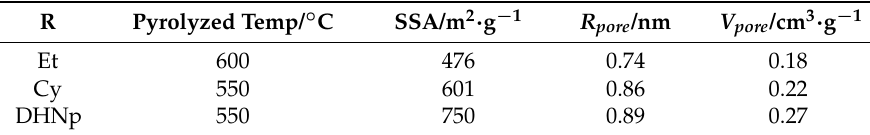
Table 5. Textural properties of ROSZ-derived amorphous Si–O–N samples.